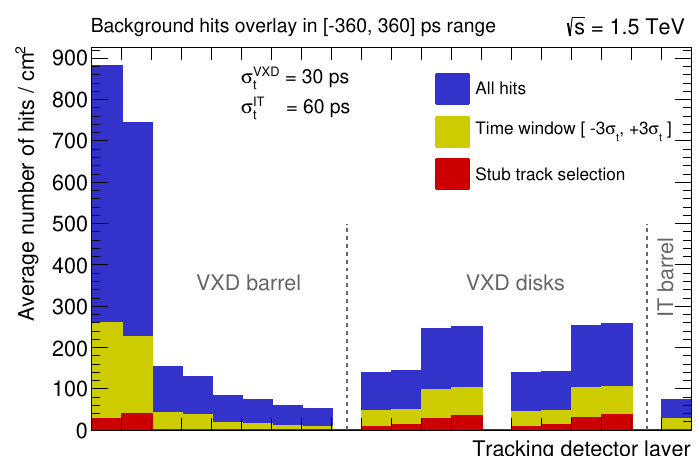
Figure 7. Hit density in the tracking detectors, shown separately for each layer of the sub-detectors √ considered in the tracklet reconstruction, for s = 1 . 5 TeV BIB. The empty bins highlight the boundaries between detector components, i.e. between the barrel and endcap disks sub-detectors and between the two sides of the detector in the disk sub-detector. The category “all hits” depends on the time window that is selected for the BIB overlay inside the simulation.